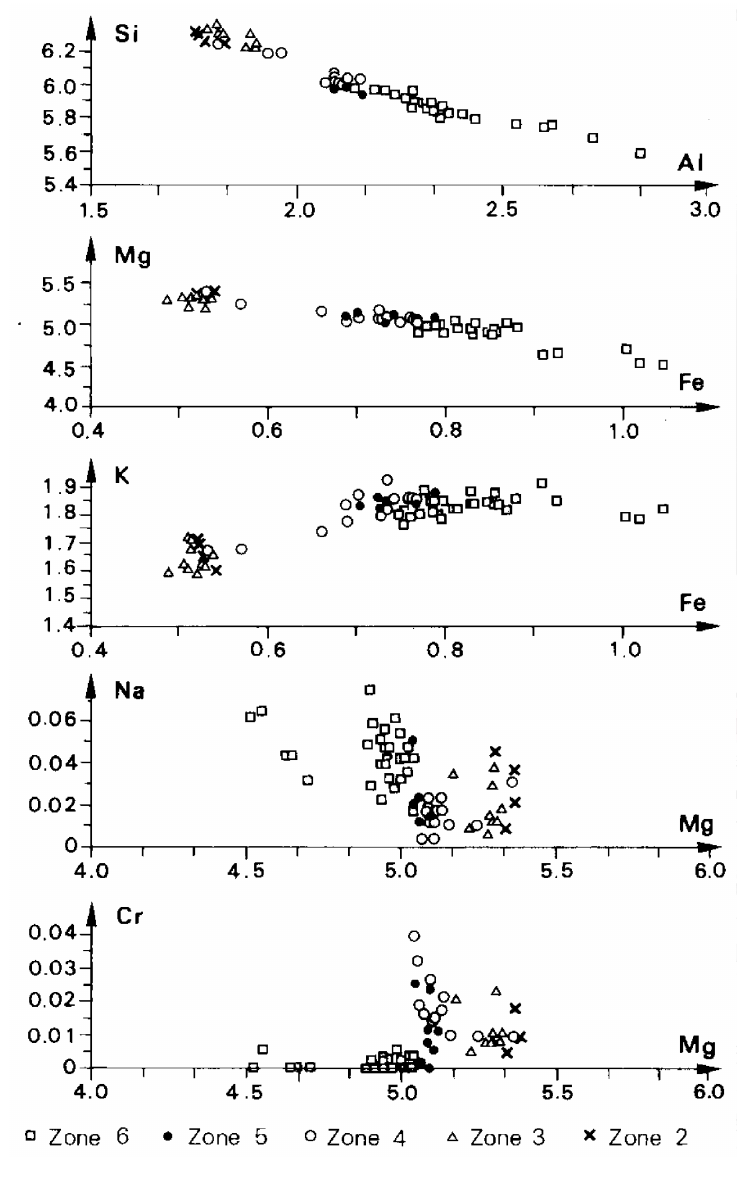
Figure 15. Evolution of the phlogopite composition in the phlogopitites of the different metasomatic zones (zones 6 to 2, see Figure 14 for the repartition of the different zones from the plagioclasite to the serpentinite) at Bra ú lia prospecting pit, Carna í ba mine, Brazil. Composition calculated in atom per formula (electron microprobe data from [79]). From the inner to the outer zones, phlogopite composition evolves with a continuous or discontinuous decrease in the Al and Fe contents and an increase of the Si and Mg contents and K/Al ratio, corresponding to changes in the petrographic habitus of the